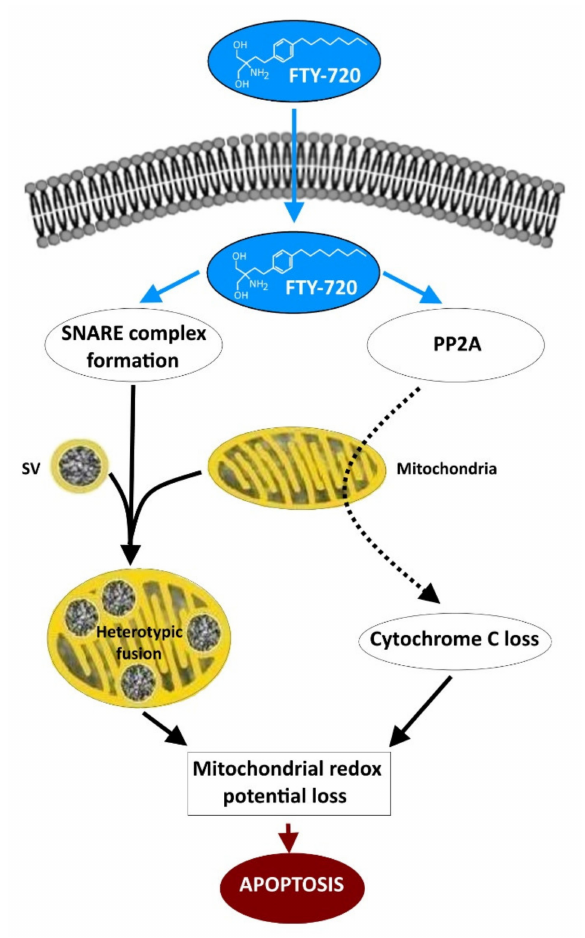
Figure 3. FTY-720 induces mitochondrial apoptosis by two different mechanisms. FTY-720 crosses